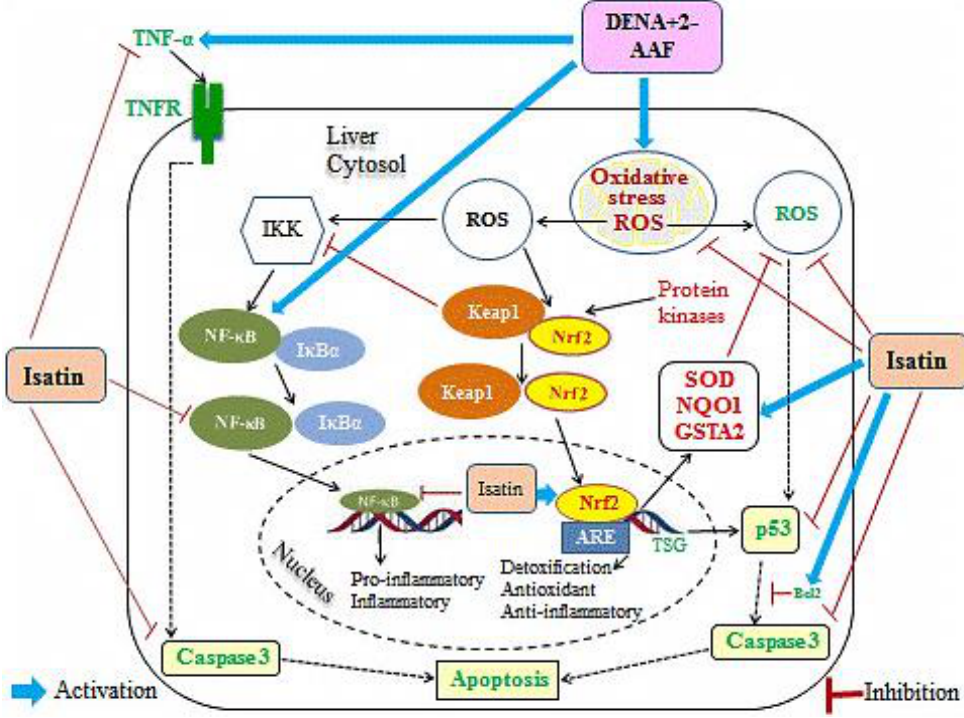
Figure 11. Schematic figure showing the mechanisms underlying isatin actions on oxidative stress, inflammation, and apoptosis in DENA/2-AAF-treated rat liver.